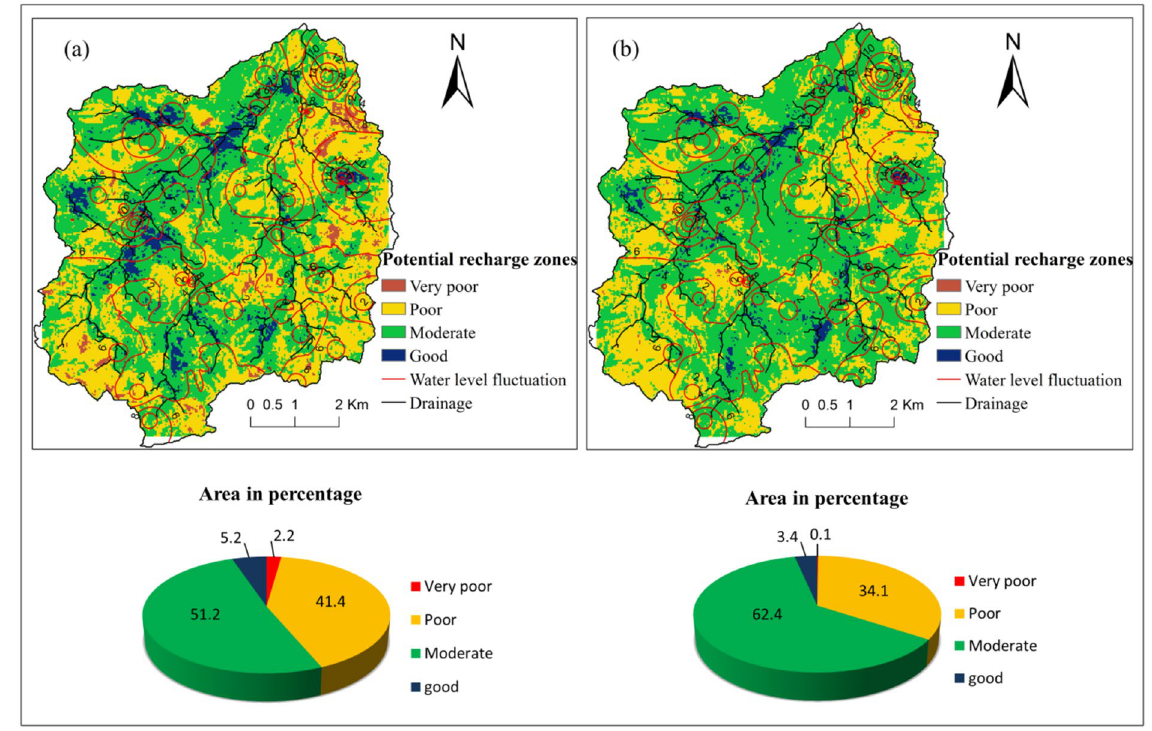
Figure 5. Potential groundwater recharge zones ( a ) without infiltration rates and basement depth ( b ) with infiltration rates and basement depth. Desktop. 10.3. ESRI, California, US. https:// deskt op. arcgis.